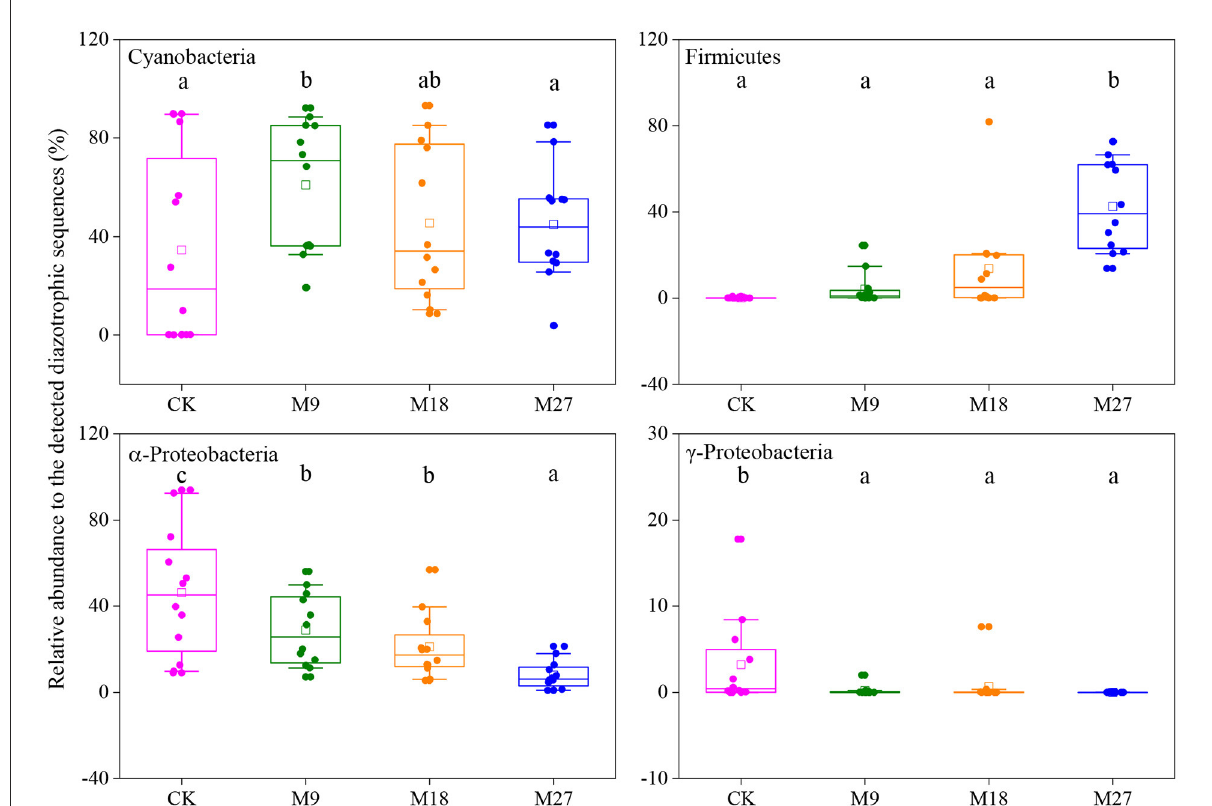
FIGURE6 Box plots of main diazotrophic phyla affected by long-term manure applications. Boundaries of boxes indicate the first and third quartiles, and lines and squares within boxes represent the median and average, respectively. Whiskers indicate the 10th and 90th percentiles, and all the data are shown as dots. Different letters represent significant differences between treatments ( p <